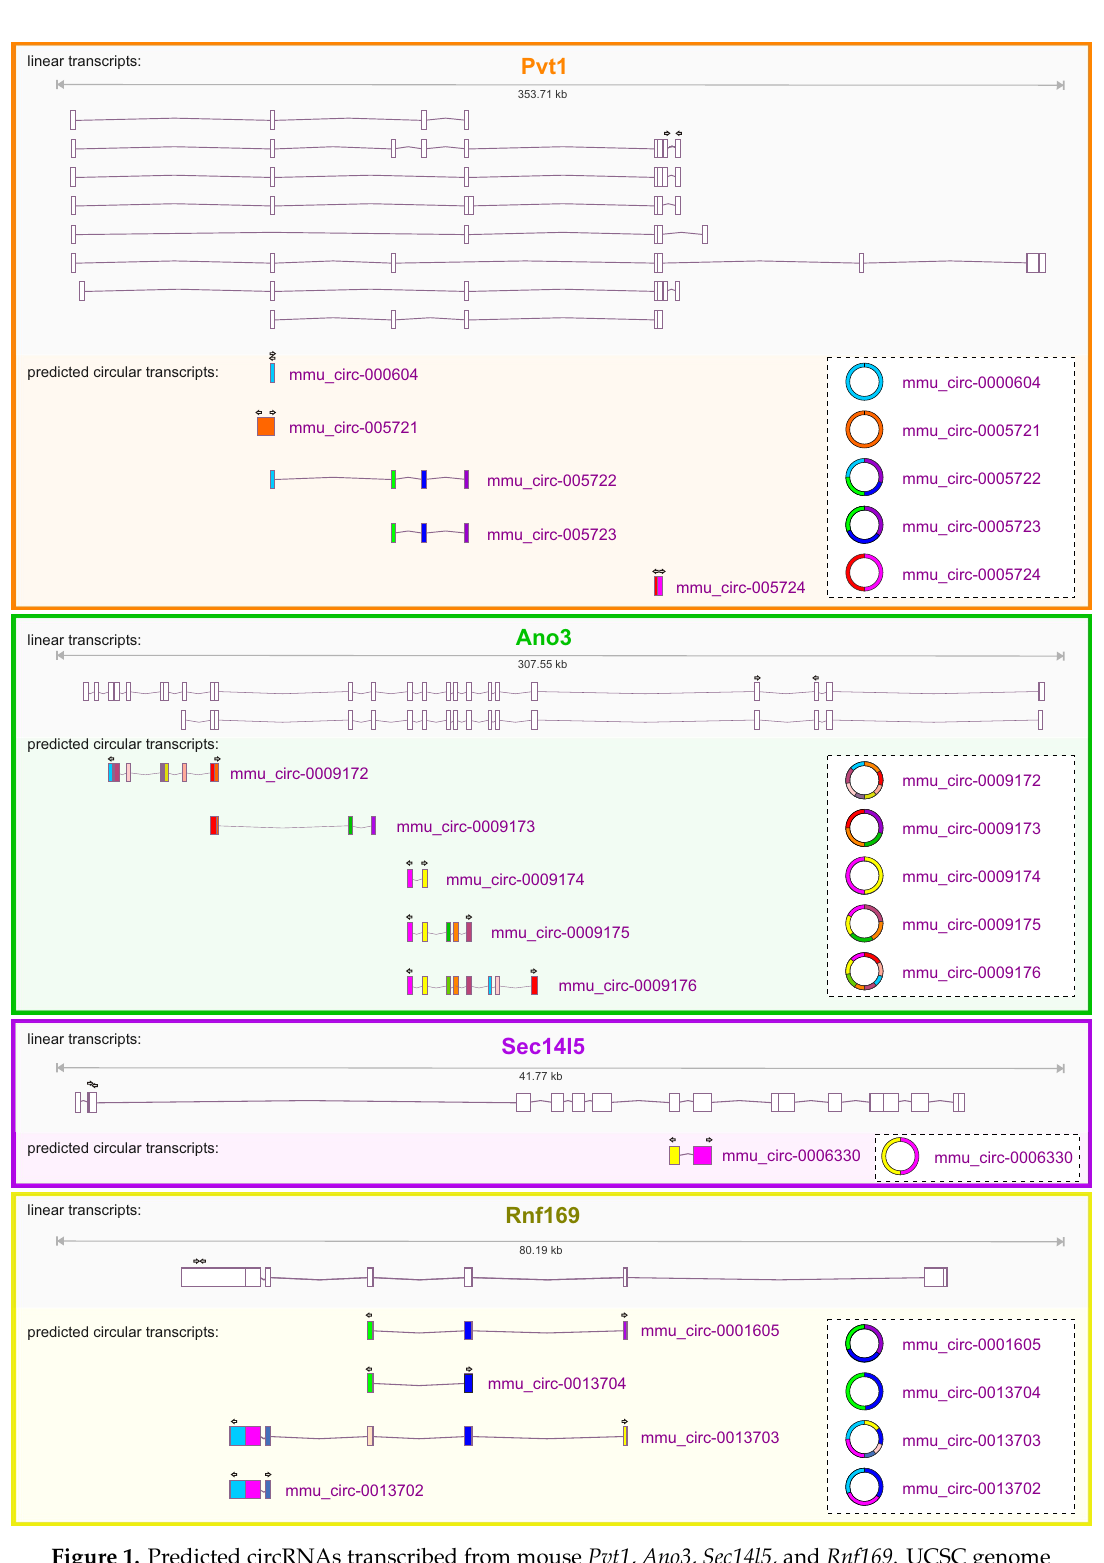
Figure 1. Predicted circRNAs transcribed from mouse Pvt1 , Ano3 , Sec14l5, and Rnf169 . UCSC genome browser views. For each gene, the upper tracks represent mRNA splice variants. The lower tracts represent the predicted circRNAs based on Memczak et al., 2013 and Rybak-Wolf et al., 2015 [6,16]. Primers used for qRT-PCR are indicated by arrows. Please note that Ano3 and Rnf169 are transcribed from the-strand and are therefore represented in the 3’ to 5’